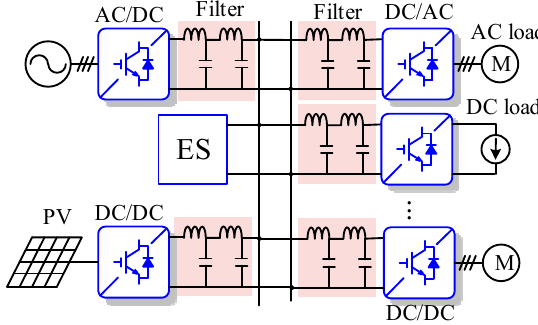
Figure 3. DC distribution network diagram containing FRF.